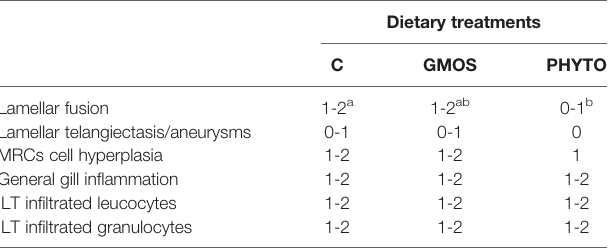
TABLE 3 | Semi quantitative evaluation of the main histopathological alterations found in the gills of juvenile European sea bass ( Dicentrachus labrax ) at the end of the feeding trial (63